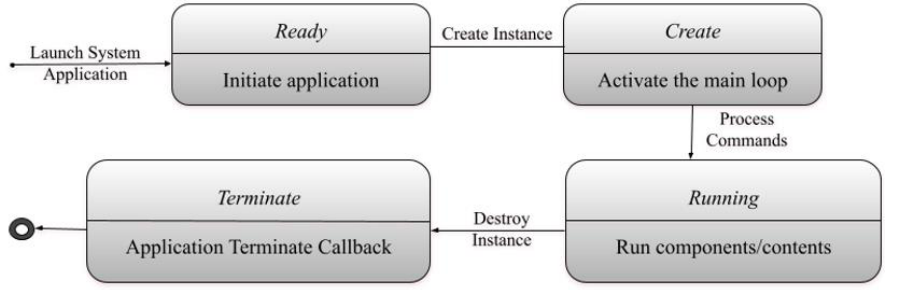
Figure 1. Module based application statuses.